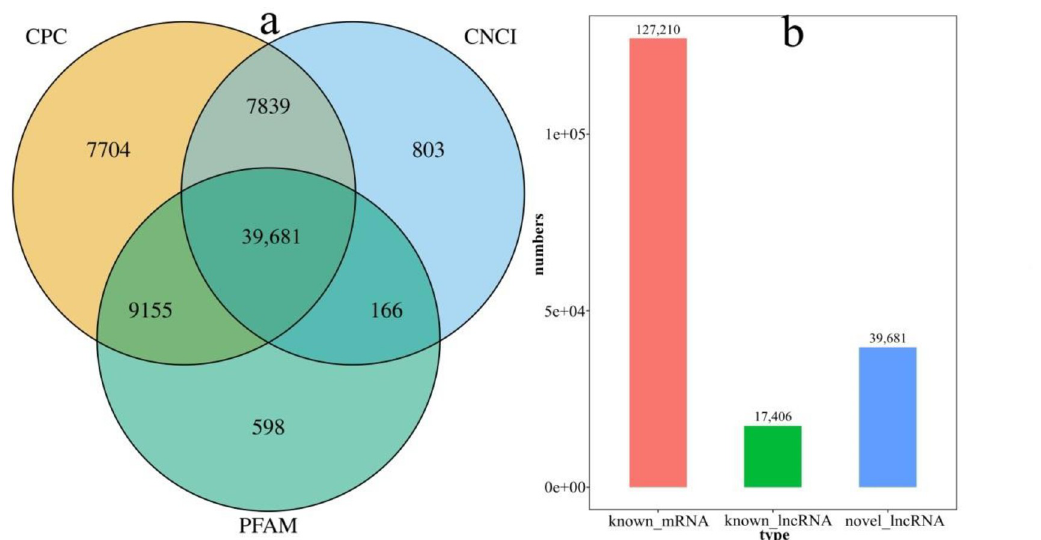
Fig 4. Number of lncRNA and mRNA. a: Venn diagram for predicting the number of novel lncRNA by three methods. b: Statistical histogram for transcripts: abscissa is the transcript type; ordinate is the number of transcripts corresponding to that transcript